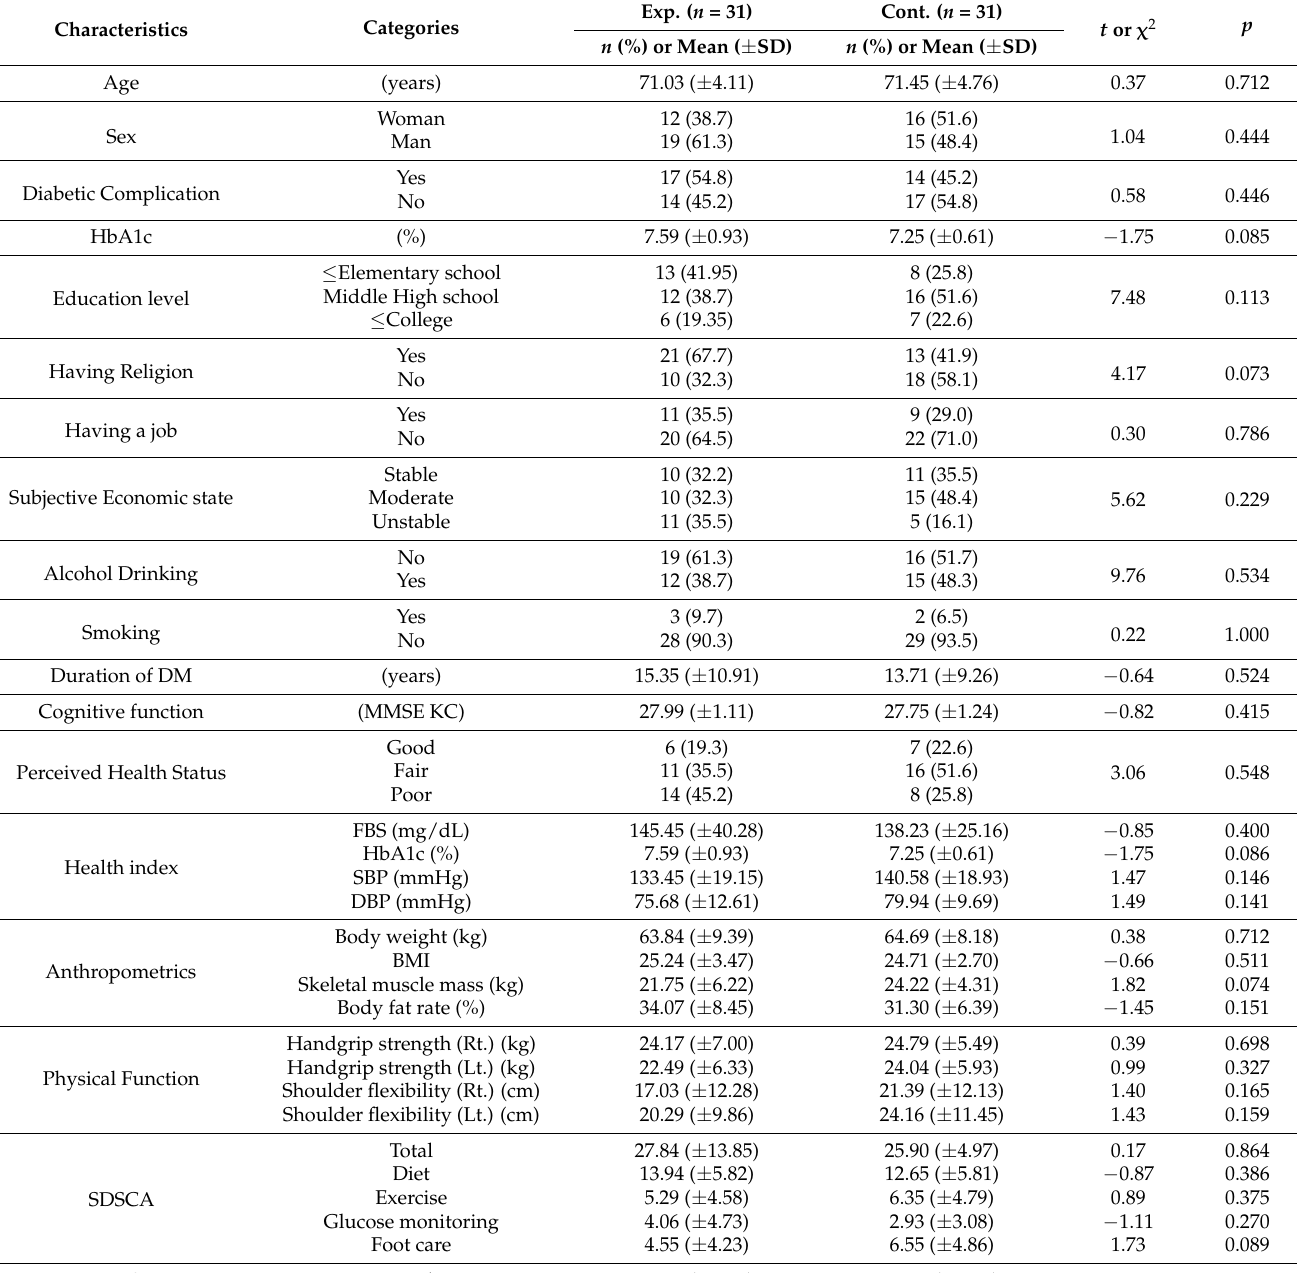
Table 2. Homogeneity